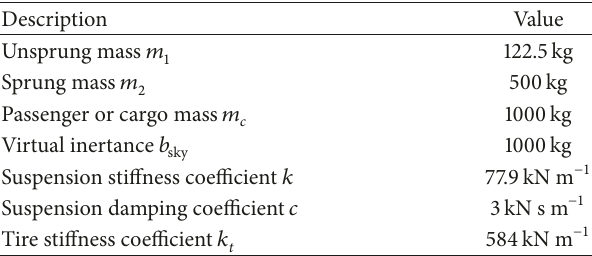
Table 2: Parameters of the quarter vehicle model.